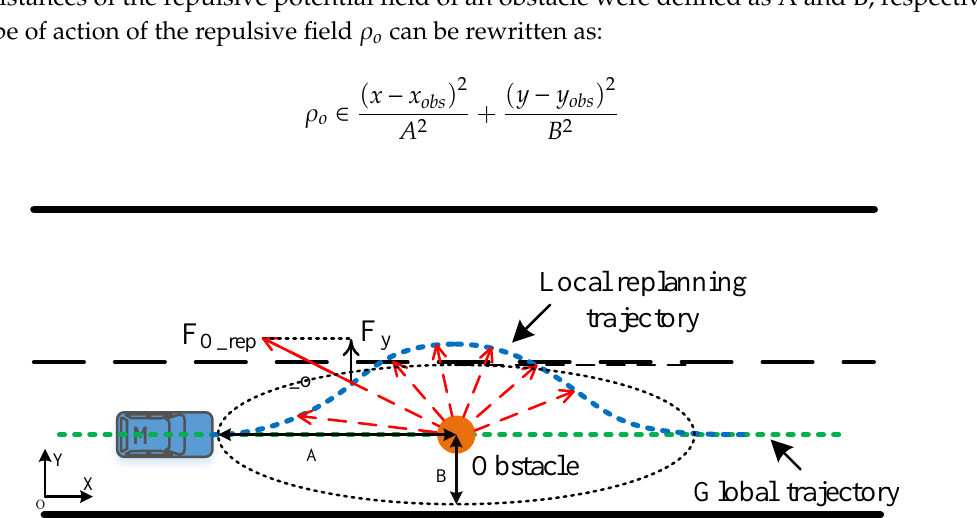
Figure 4. Schematic diagram of the road boundary repulsive potential field force.